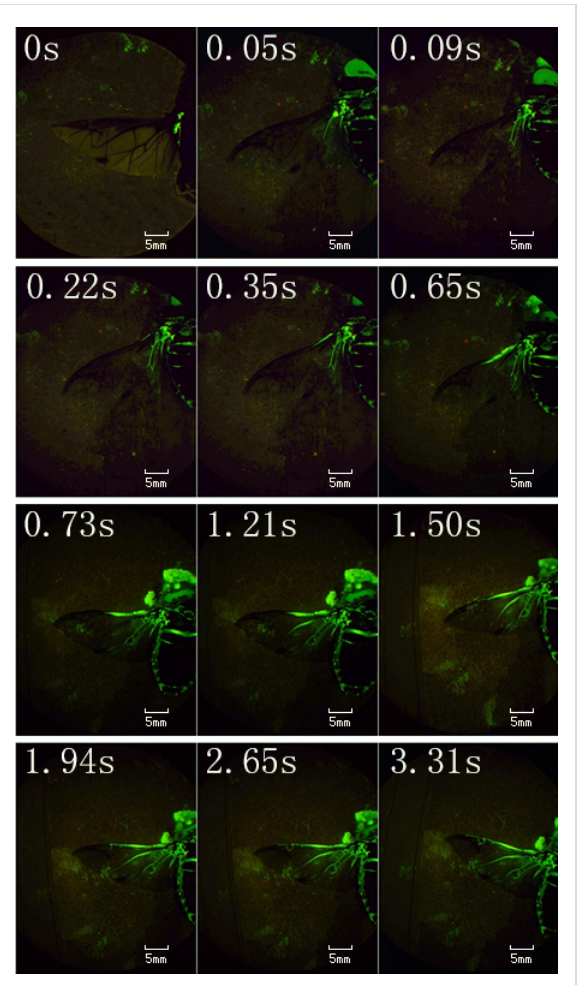
Figure 4: Fluorescence flow sequence in an unfolding hind wing of C. japonicus , captured using a retinal camera.